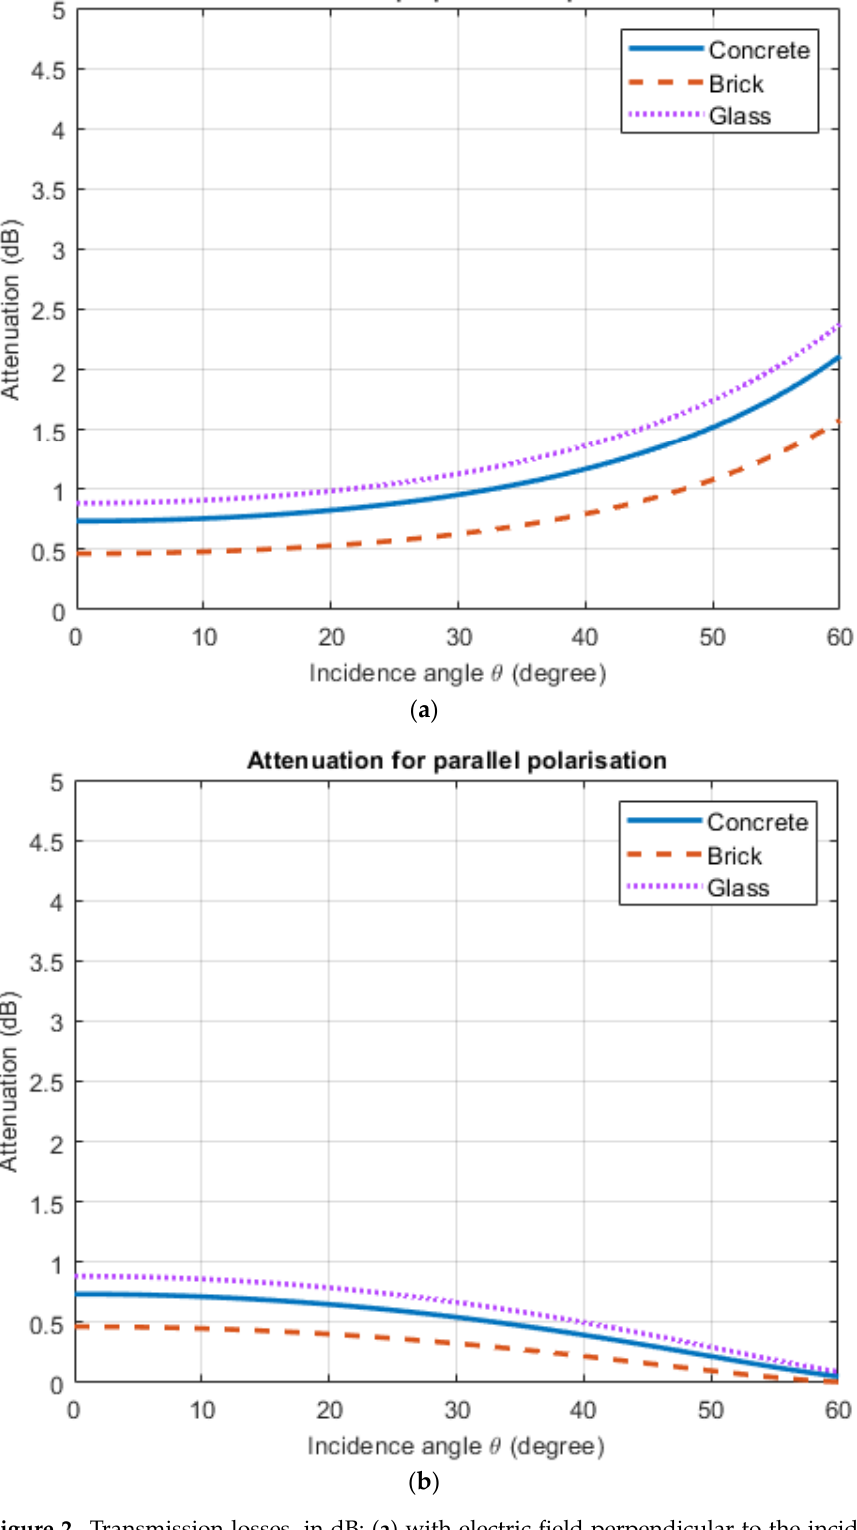
Figure 2. Transmission losses, in dB: ( a ) with electric field perpendicular to the incidence plane; ( b ) with electric field parallel to the incidence plane.